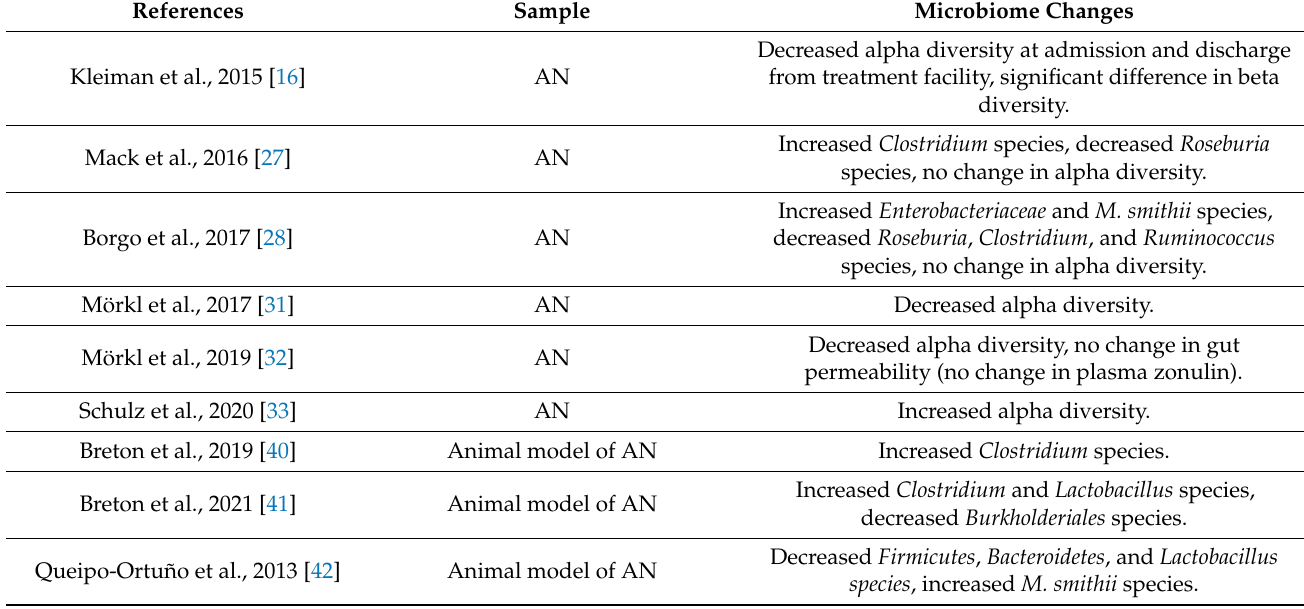
Table 1. Examination of the gut microbiome in anorexia nervosa (AN) and animal models of